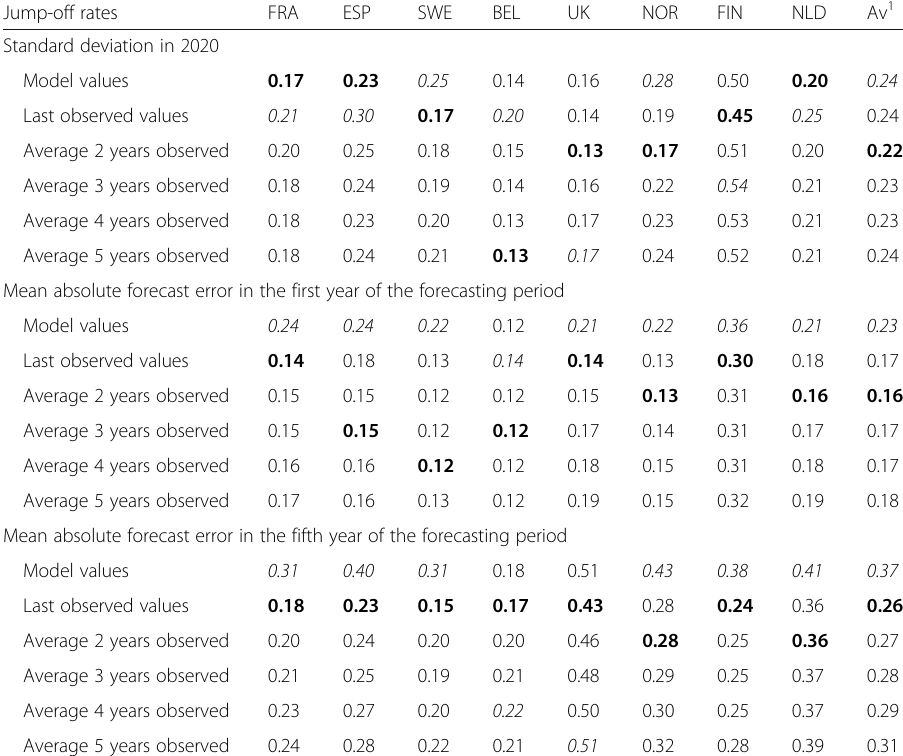
Table 4 Mean absolute forecast error (MAFE) of remaining life expectancy at age 65 for the first and fifth year in the forecasting period and standard deviation (SD) of the increase/decrease of the life expectancy at age 65 in 2020 between ten successive forecasts, for six different choices of the jump-off rates applied to a Lee-Carter model with three principal components, for eight Western European countries, men and women combined, fitting periods 1960 – 2005, 1960 – 2006, … , 1960 –